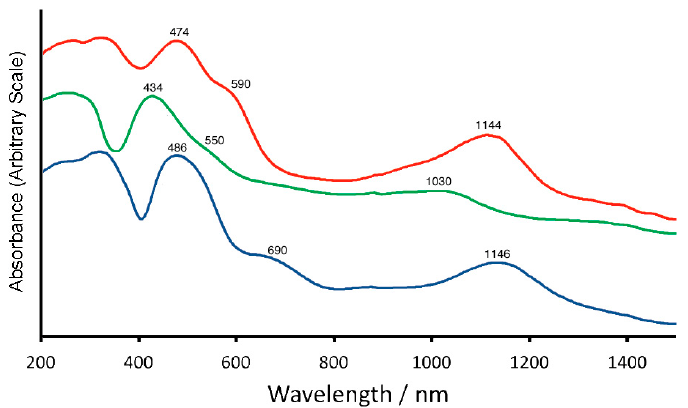
Figure 9. Diffuse reflectance spectra of 1 (—), 2 (—), and 3 (—).